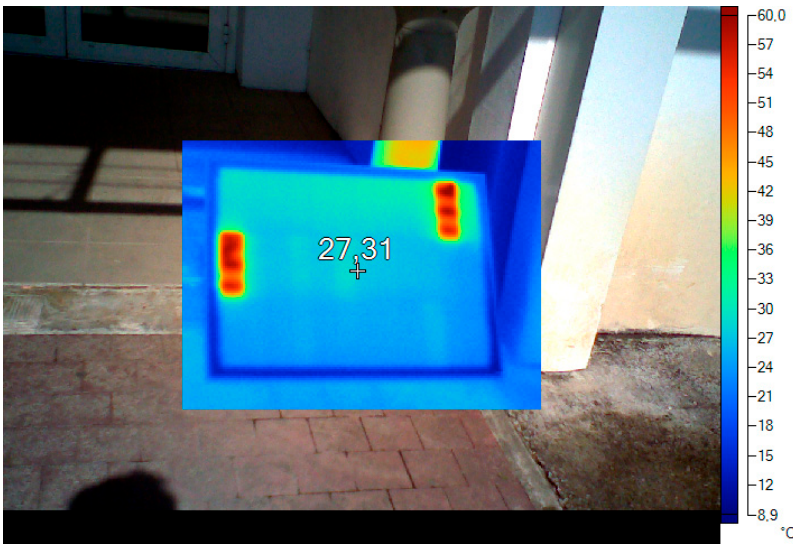
Figure 13. Thermal images of the panel exposed to sunlight. Cell 12 and Cell 212 are significantly hotter than the rest.